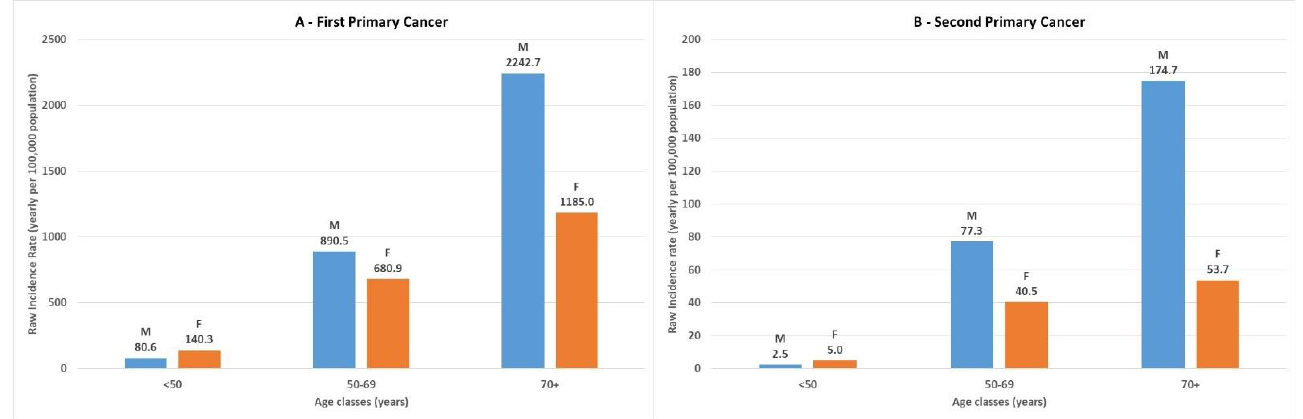
Figure 3. The raw incidence rate data in patients from RTI 2003–2017, by age class, at diagnosis of the FPC. M, males, F, females; <50 = aged 0–49; 50–69 = aged 50 to 69 years old; 70+ = aged 70 and above. Table 2. Percentage frequency of a second primary cancer (SPC) in the years 2003–2017, in cancer patients diagnosed in 2003–2007 with a first primary cancer (FPC), in overall data, and within 6 months (synchronous) or metachronous: between 7 months and 5 years (7–60 months) from the first diagnosis, or after 5 years (>60